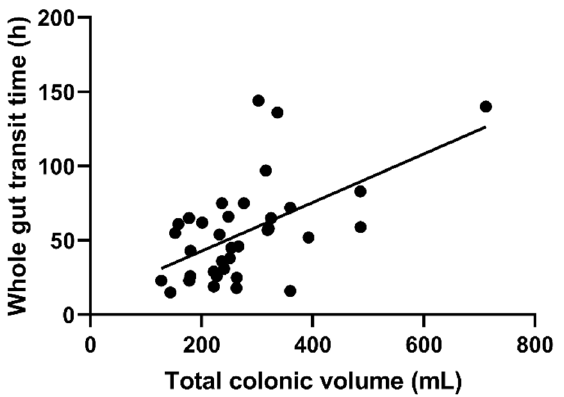
Figure 4. Correlation between whole gut transit time (WGTT) and total colonic volume, corrected for body surface area, for 19 controls and 16 patients with constipation coefficient of correlation R = 0.56, p =0.0005.